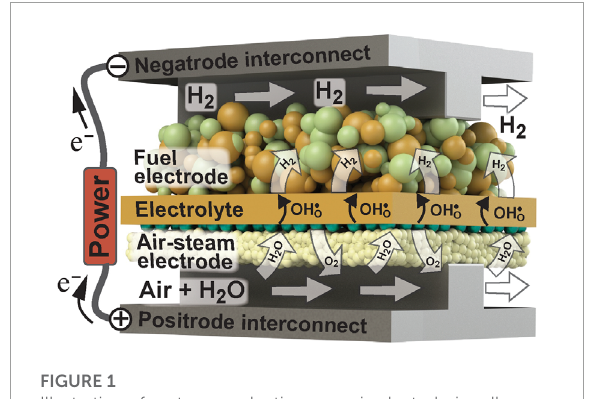
FIGURE 1 Illustration of proton-conducting ceramic electrolysis